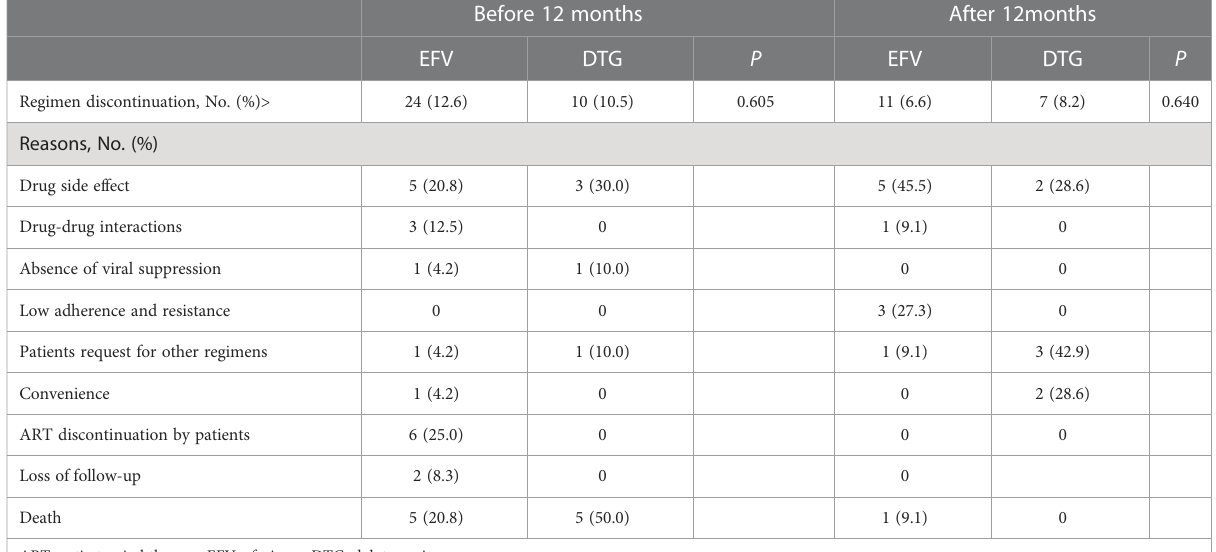
TABLE 2 Treatment discontinuation during the follow-up